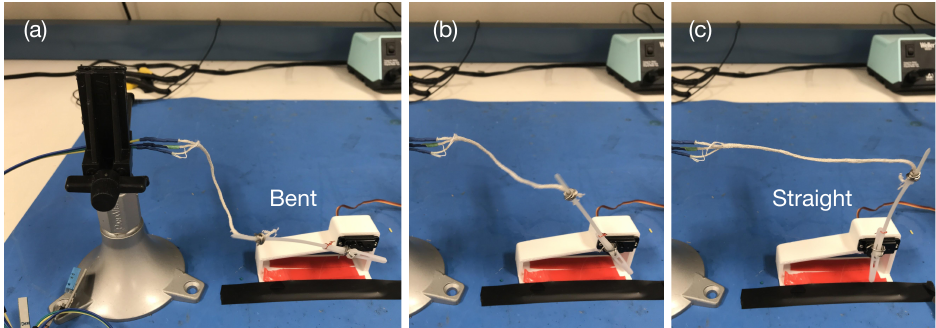
Figure 9. Sensor characterization with motion caused sensor bending. ( a ) fully bent, motor position is